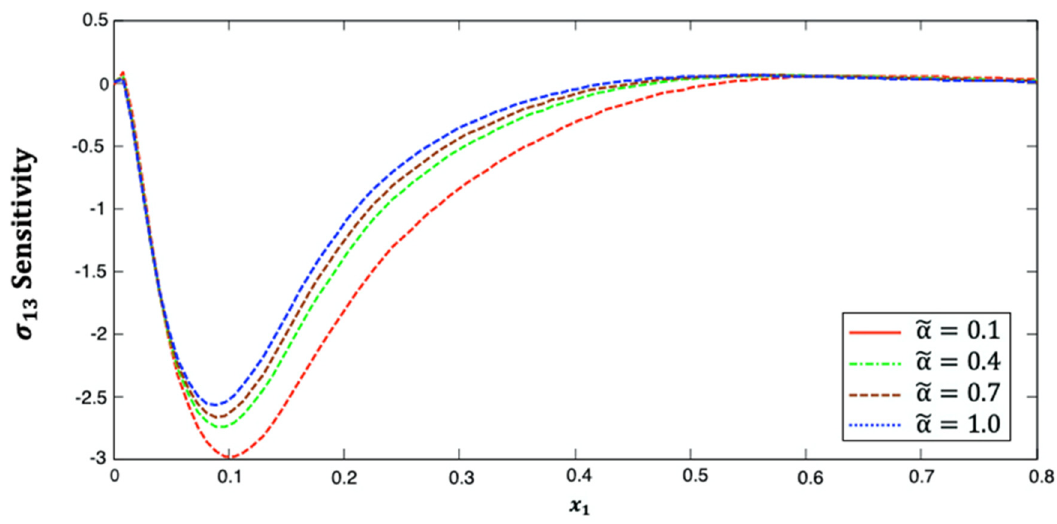
Figure 5. Distribution of the σ 13 sensitivity along x 1 –axis in anisotropic FRP composites for various fractional-order values.